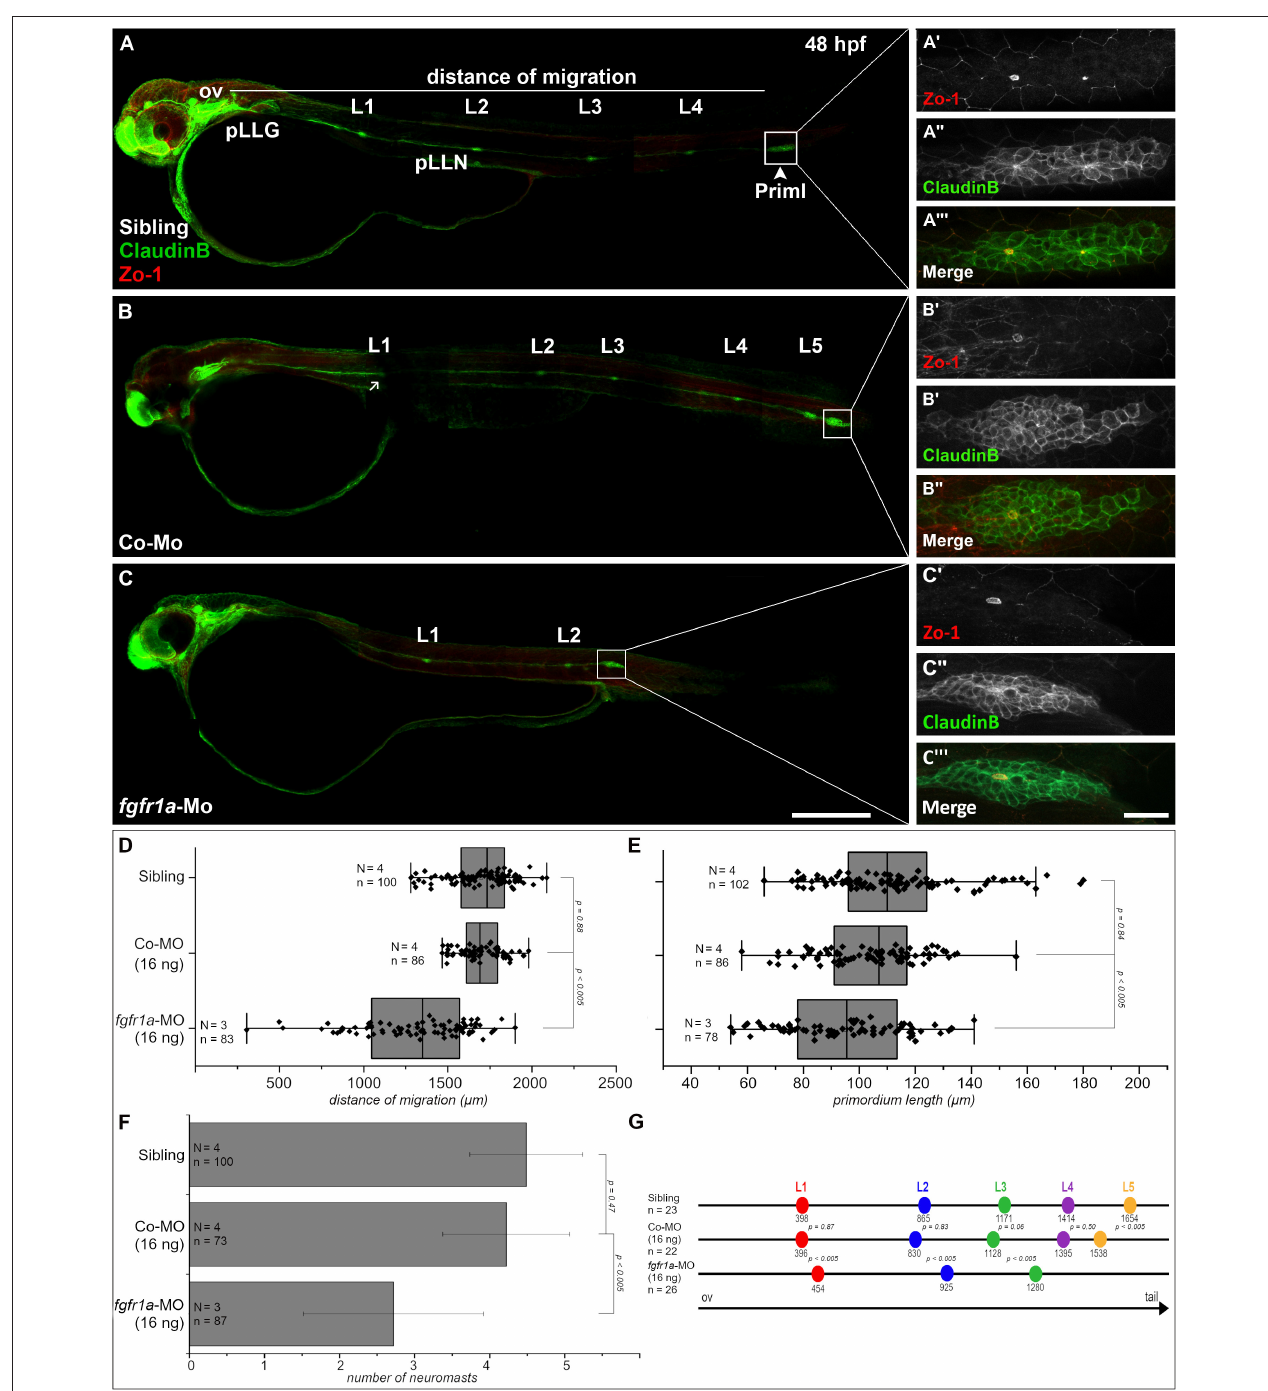
FIGURE 5 | Fgfr1a is important for posterior lateral line development. Lateral views of 48 hpf Tg(ClaudinB::lynGFP) (green) embryos. (A,B) In siblings and control-morpholino injected embryos Priml has reached the tip of the tail and deposited 5 neuromasts. (C) fgfr1a- knockdown embryos show a delayed migration of primordia and a reduced number of neuromasts. (A ′ -C ′ ) Apical constriction, visualized by staining of Zo-1, occurs under all conditions. Quantification of (D) migration distance, (E) primordium length, (F) number and (G) spacing of neuromasts, respectively. Error bars in bar chart represent standard deviation. Scale bars (A,B) 200 µ m, (A ′ -C ′′ ) 20 µ m. Abbreviations: Co-Mo, Control-Morpholino; L1-6, lateral (pro)neuromast; pLLGg, lateral line ganglion; pLLN, lateral line nerve; ov, otic vesicle; PrimI, primary posterior primordium.